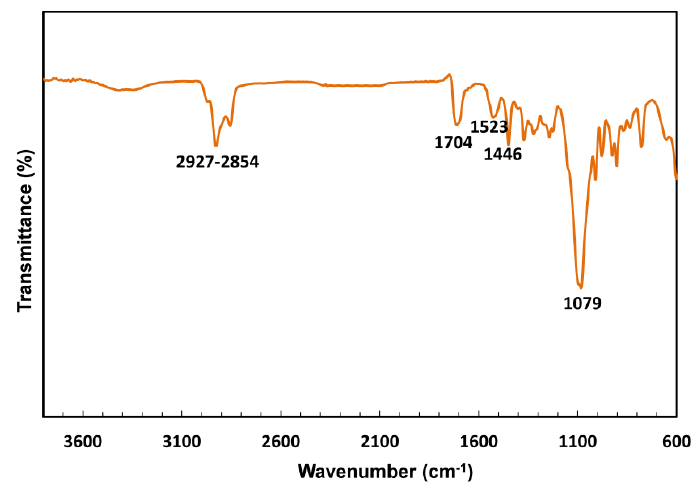
Figure 5. The FTIR spectrum of the polyurethane PU4 .